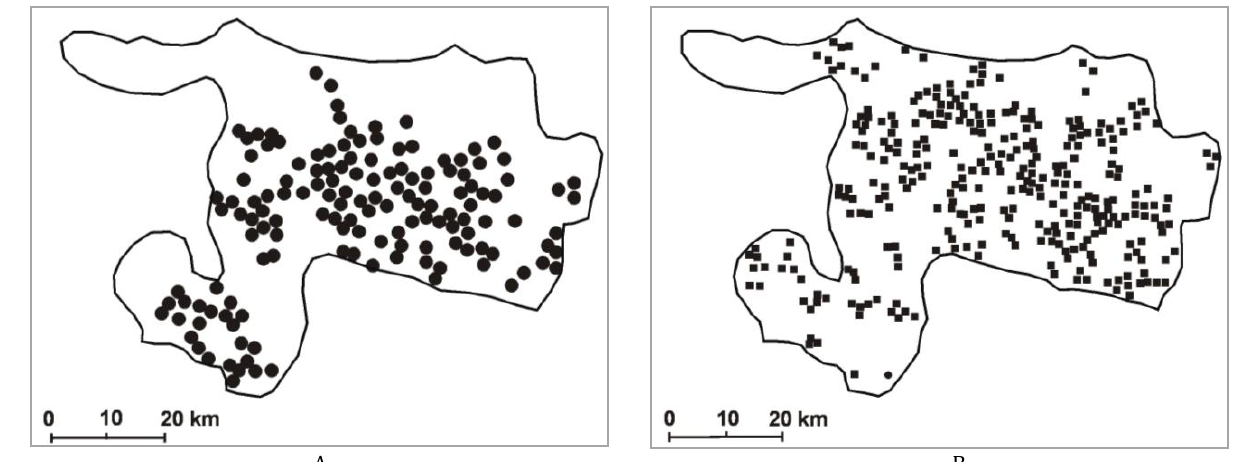
Fig. 2. Distribution of excavations (A) and spoil tips (B) in the Silesian Upland (made by the author on the base of aerial photos and topographic